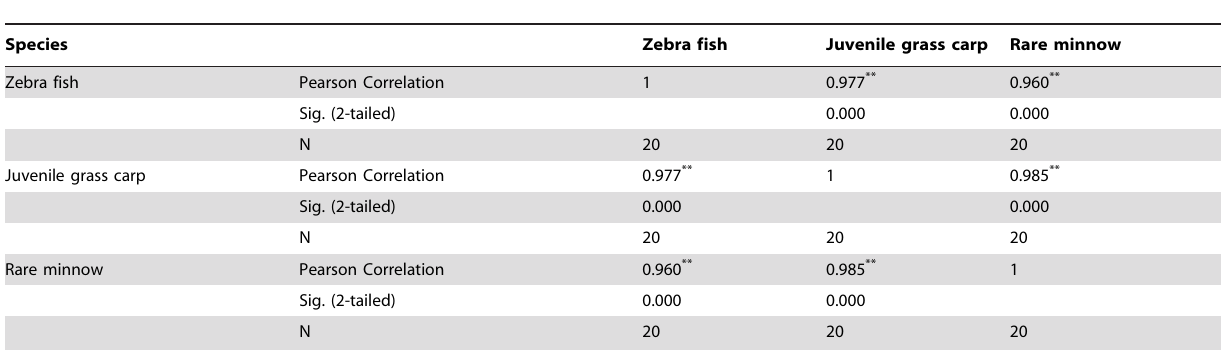
Table 1. Correlation analysis among the toxicity of the 4 heavy metals to the 3 Cyprinid Fish species.